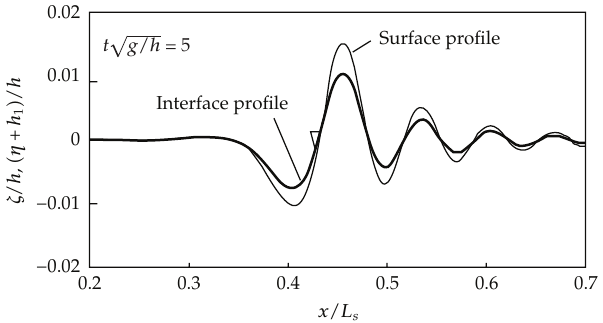
(cid:19) g/h (cid:7) 5 . 0, when the point load stops movement,